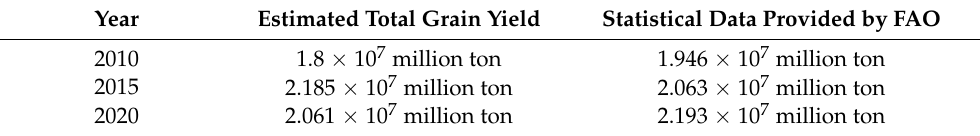
Table 8. Estimated and statistical results of the total grain yield in Egypt in 2010, 2015, and 2020.